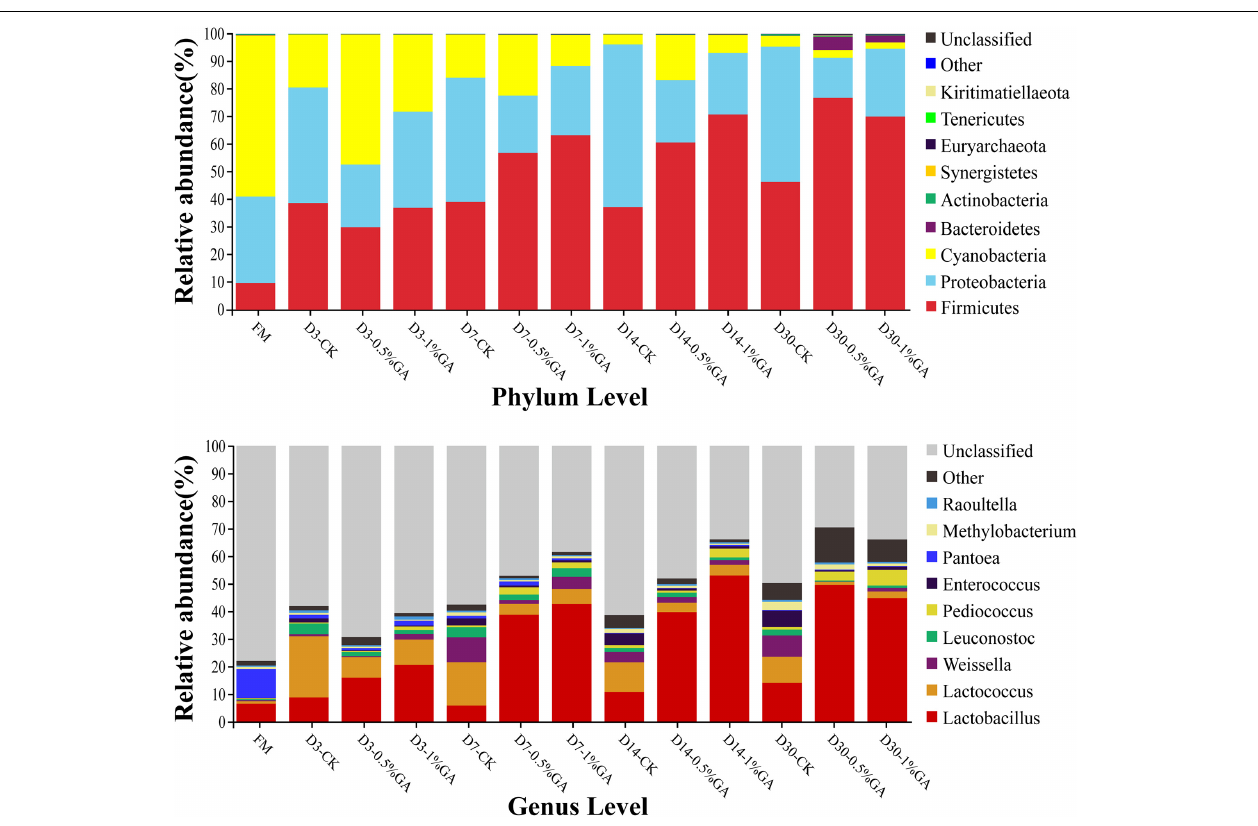
FIGURE 3 | Relative abundance of bacterial communities at the phylum and genus levels for whole plant soybean silage with and without the addition of gallic acid (GA) (FM, fresh matter; CK, blank control; 0.5% GA, 0.5% FM GA addition; 1% GA, 1% FM GA